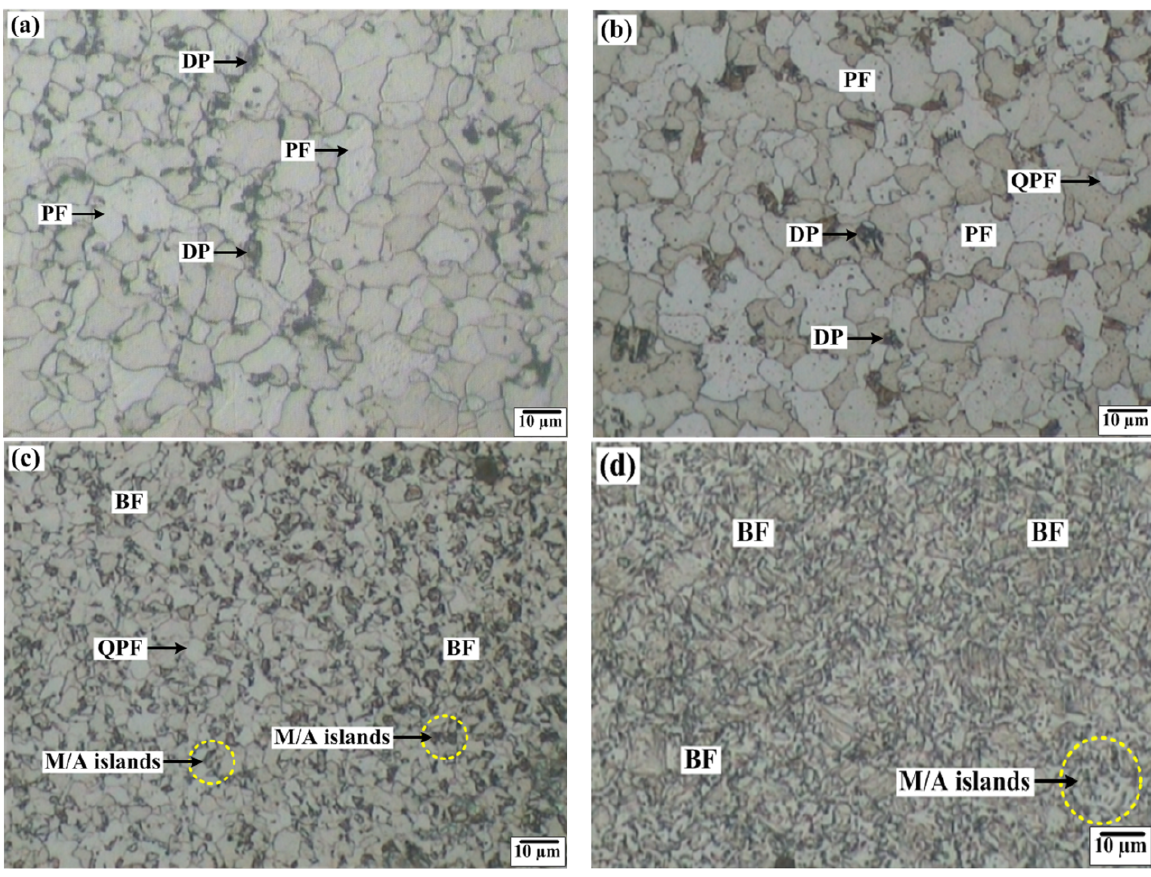
Figure 2: The light microstructures of various weld simulated API 5L X-60 pipeline steel samples under different cooling rates: (a) 0.3; (b) 10; (c) 50; and (d) 360 ∘ C/s. Degenerate pearlite, polygonal ferrite, quasi-polygonal ferrite, plate-like bainitic ferrite, and martensite/austenite island microconstituents are marked in the figures with DP, PF, QPF, BF, and M/A islands symbols,